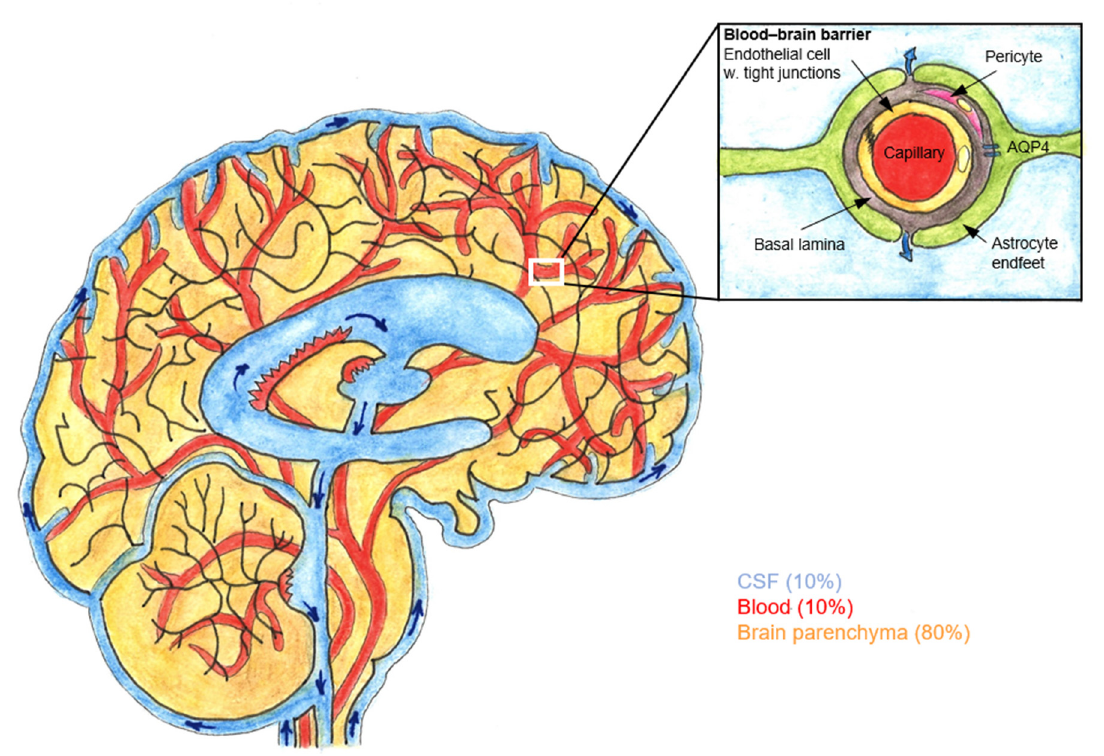
Figure 1. The blood–brain barrier (BBB) and glymphatic pathway. Sagittal section of brain and the surrounding subarachnoid space containing cerebrospinal fluid (CSF). The location of the perivascular space is between the endothelial cells and astrocytic endfeet. CSF flows from the subarachnoid space into the arterial perivascular spaces. From the perivascular space, CSF diffuses into brain parenchyma via astrocytic endfeet that express water channel aquaporin 4 (AQP4). Adapted from Jessen et al. (2015). Drawn by Lassi Piirainen.